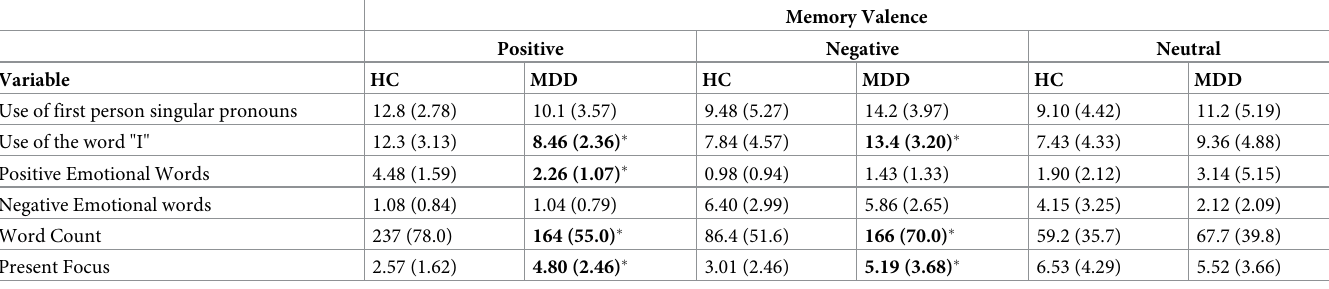
Table 1. Means and SD for linguistic variables for each memory valence and